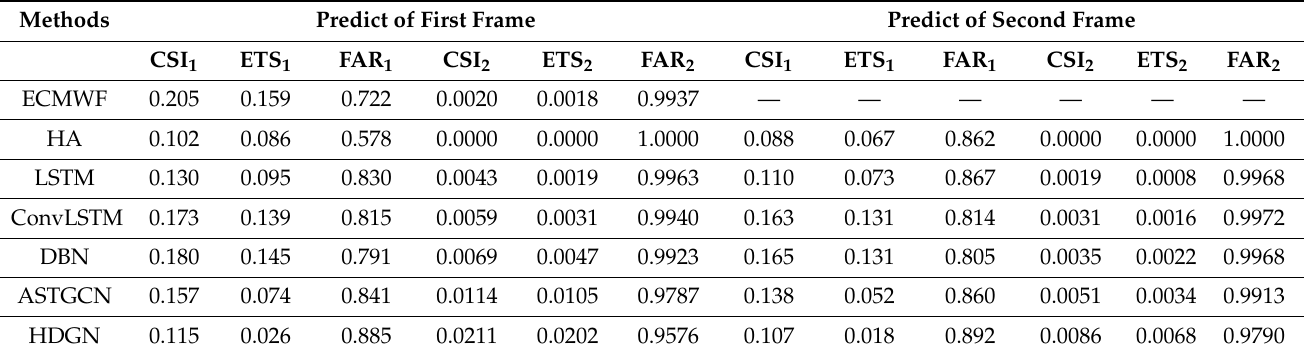
Table 4. Short-term intensive rainfall prediction performance of the baseline and proposed methods on the S-ECMWF dataset in the future first and second